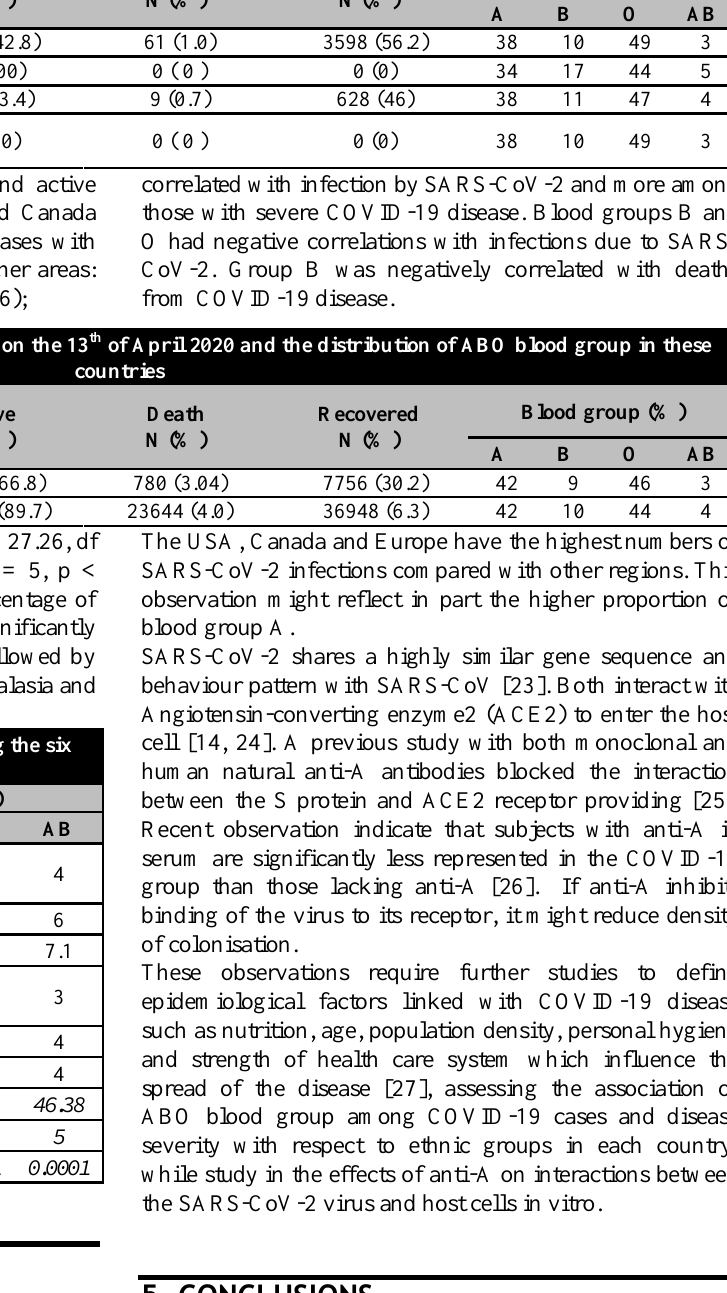
Table 5. COVID-19 in 4 Australasian Countries on the 13 th of April 2020 and the distribution of ABO blood group in these Countries